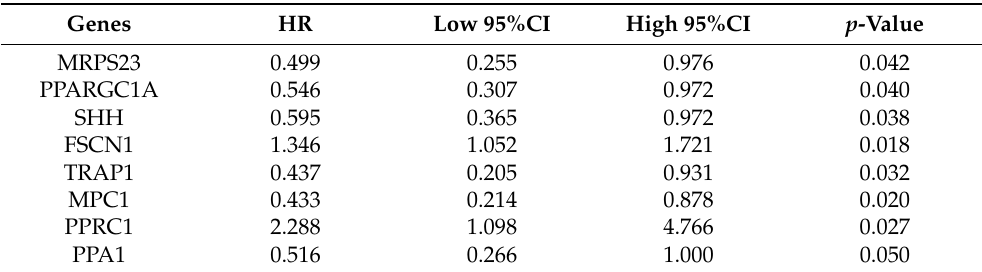
Table 1. Univariate COX regression analysis of eight OXPHOS-related genes in COAD in the training